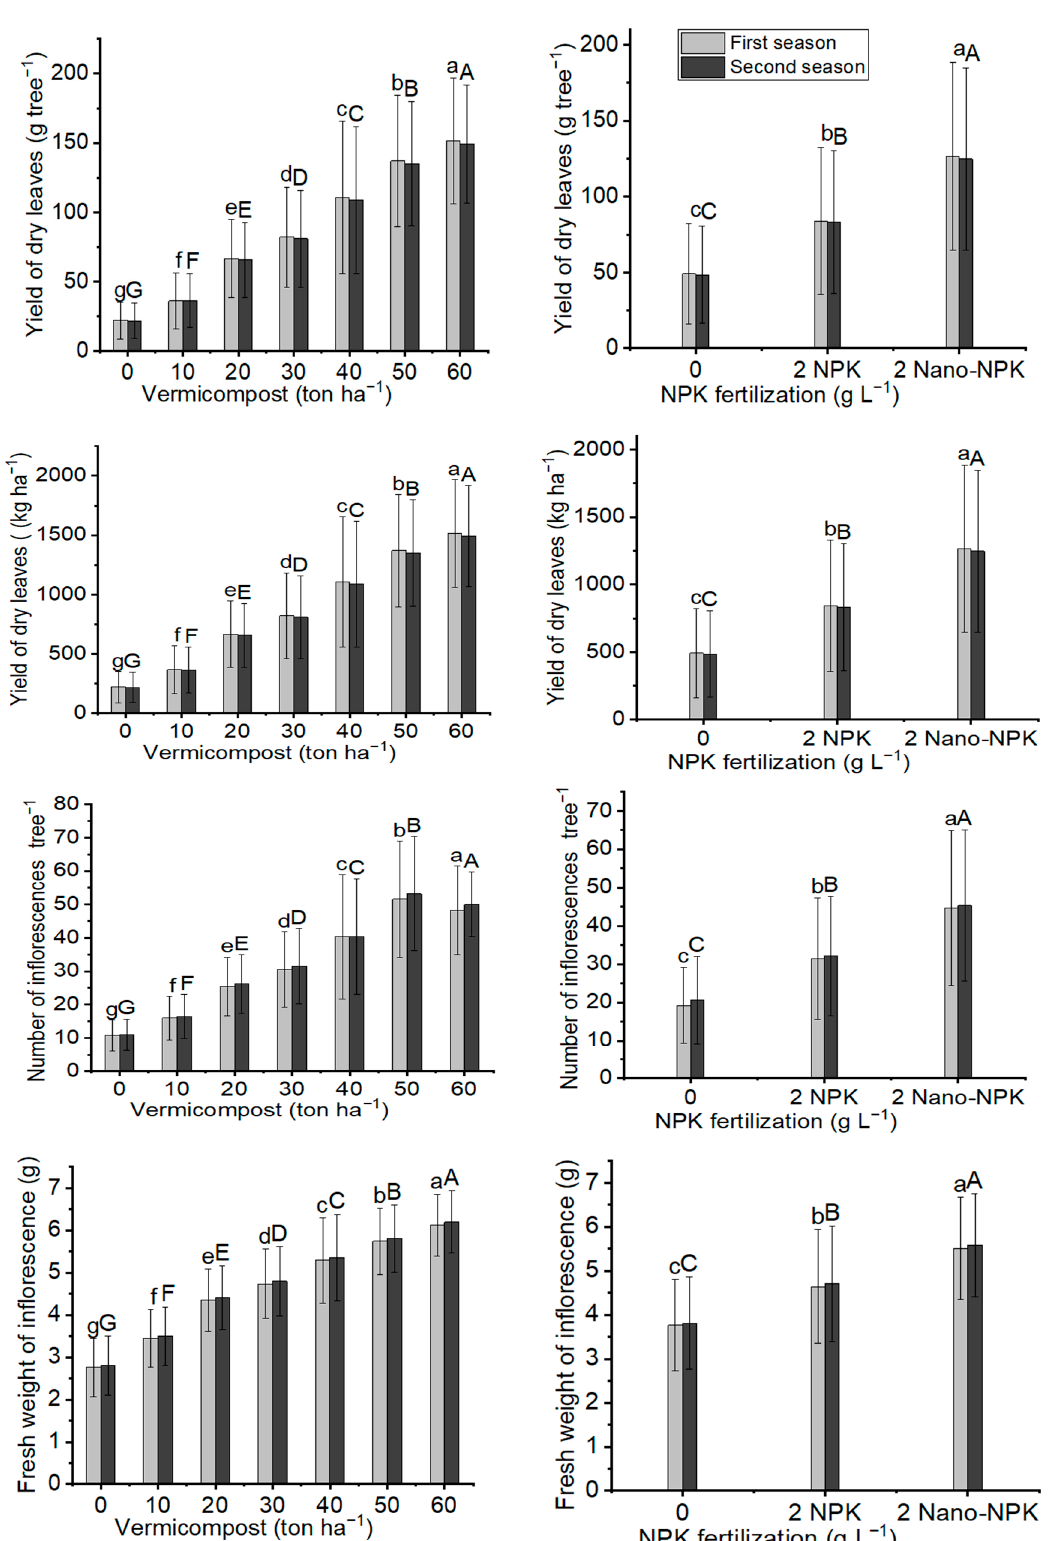
Figure 3. In both seasons of the study, the mean values of yield of dry leaves (g tree − 1 ), yield of dry leaves (kg ha − 1 ), number of inflorescences per tree, and fresh weight of inflorescence (g ) of Moringa oleifera trees as influenced by vermicompost and NPK fertilization are provided below. The data are presented as a mean with standard error ( n = 3). Bars with identical lowercase letters are not significant at the 0.05 level of probability.